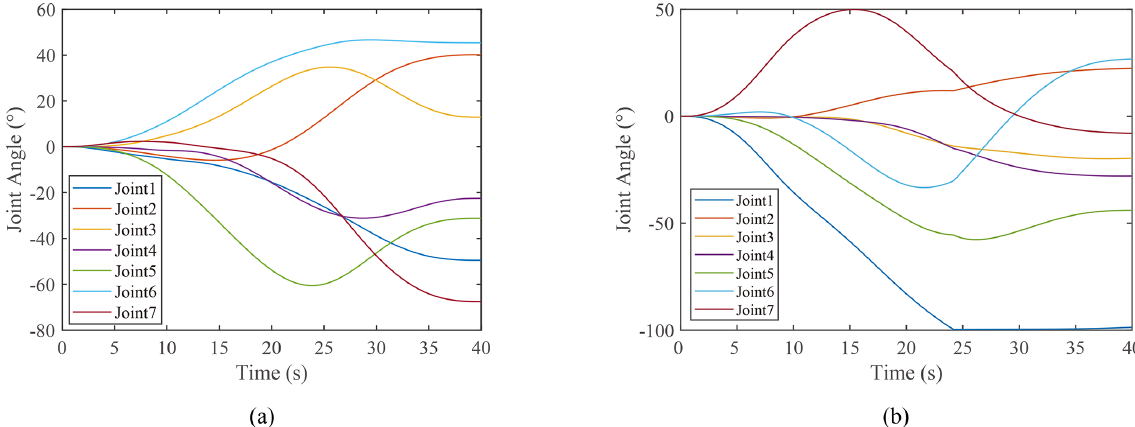
Figure 11. The change of joint angular. (a) Solution 2. (b) Solution 3.